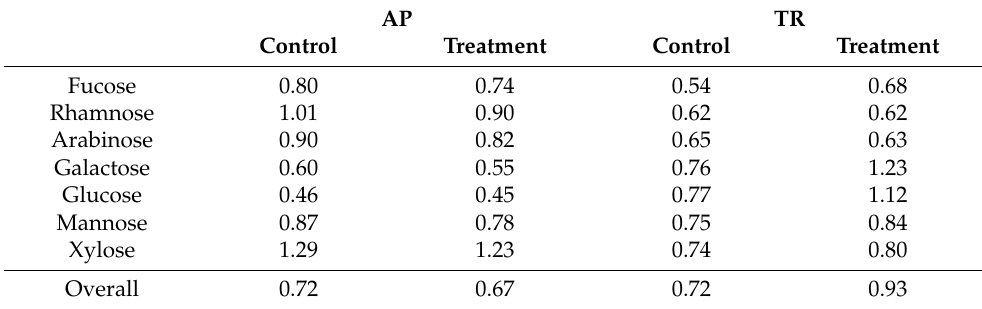
Table 5. Enrichment factor (EF) on particulate hydrolysable neutral aldose (PHNA). Abbreviations: AP: coastal Avery Point site; TR: estuarine Thames River site. Treatment denotes samples after two days of rolling, and control denotes samples incubated for two days without